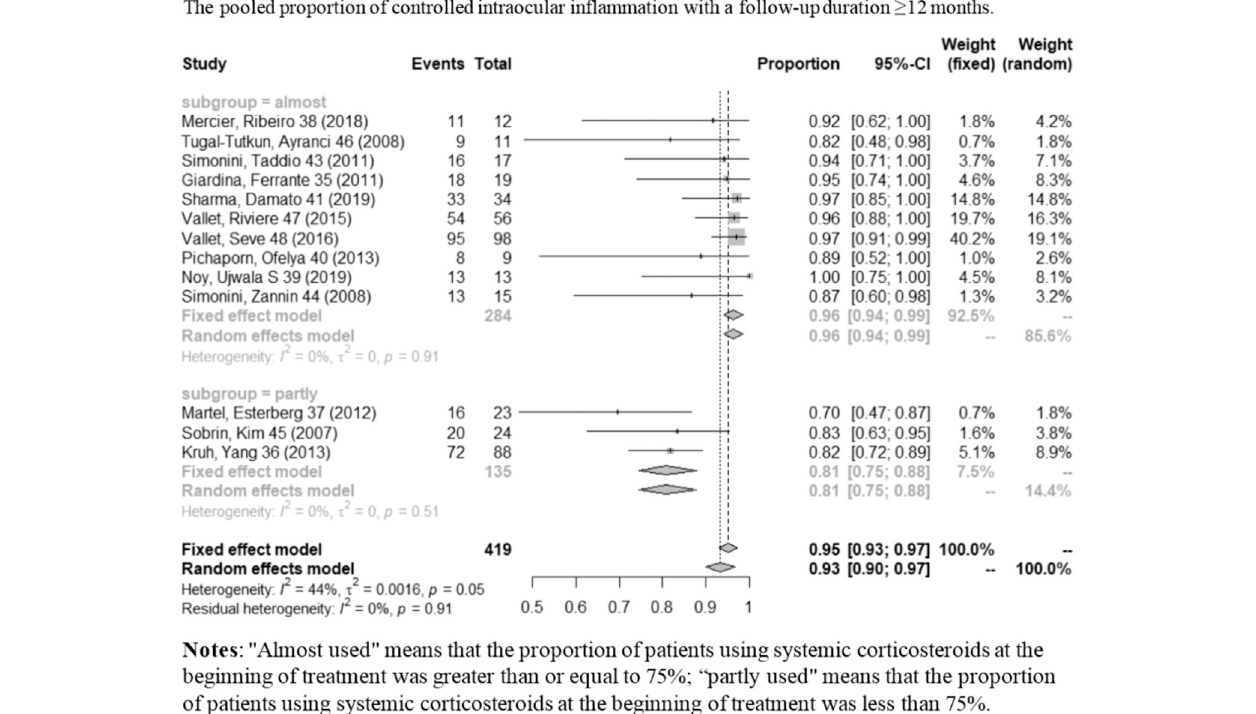
FIGURE 4 | Pooled proportion of controlled intraocular in fl ammation with a follow-up duration of ≥ 12 months.